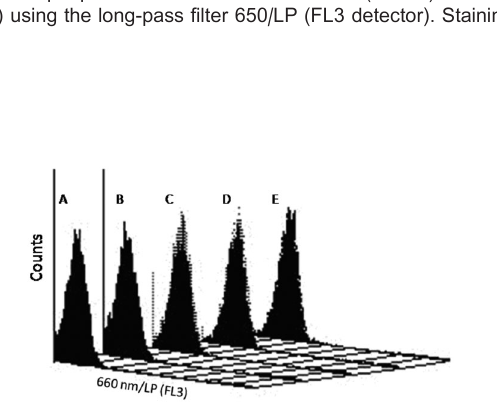
Figure 4. Histogram analysis of the trypan blue (TB) exclusion assay by flow cytometry to evaluate TB (at 0.002%, w/v) incorporation by live cells 0 ( A ), 5 ( B ), 10 ( C ), 20 ( D ), and 30 ( E ) min after dye